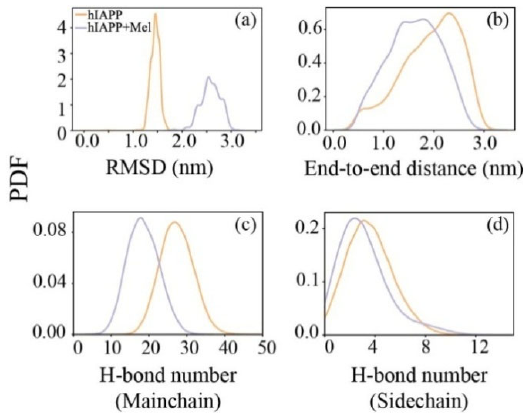
Figure 3. PDF of C α -atom RMSD ( a ), end-to-end distance ( b ), and H-bond number of the peptide main chain ( c ) and side chain ( d ) for the hIAPP 20–29 octamer in the absence and presence of Mel. The two-dimensional free energy landscape as a function of the solvent-accessible surface area (SASA) and the radius of gyration (RG) of hIAPP 20–29 in Figure 4a,b